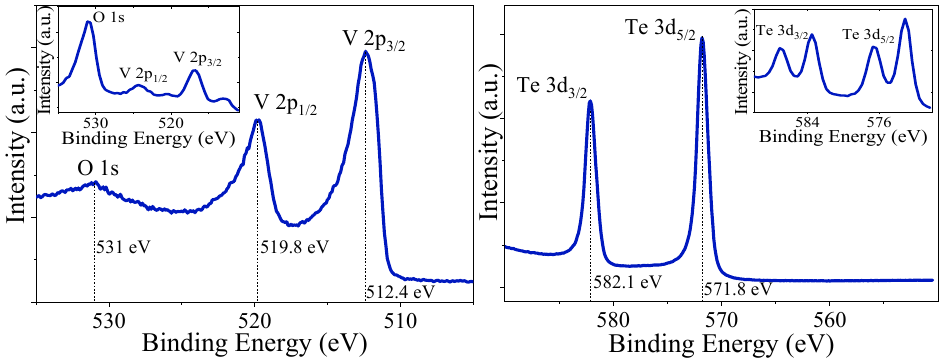
Figure 2. In situ high-resolution XPS spectra of a 5 nm VTe 2 thin films deposited on Al 2 O 3 substrates showing solely V-2p and Te-3d doublet peaks, respectively, indicating homogeneous phases of 1T-VTe 2 . Insets: ex situ measurements showing the presence of oxidized states.